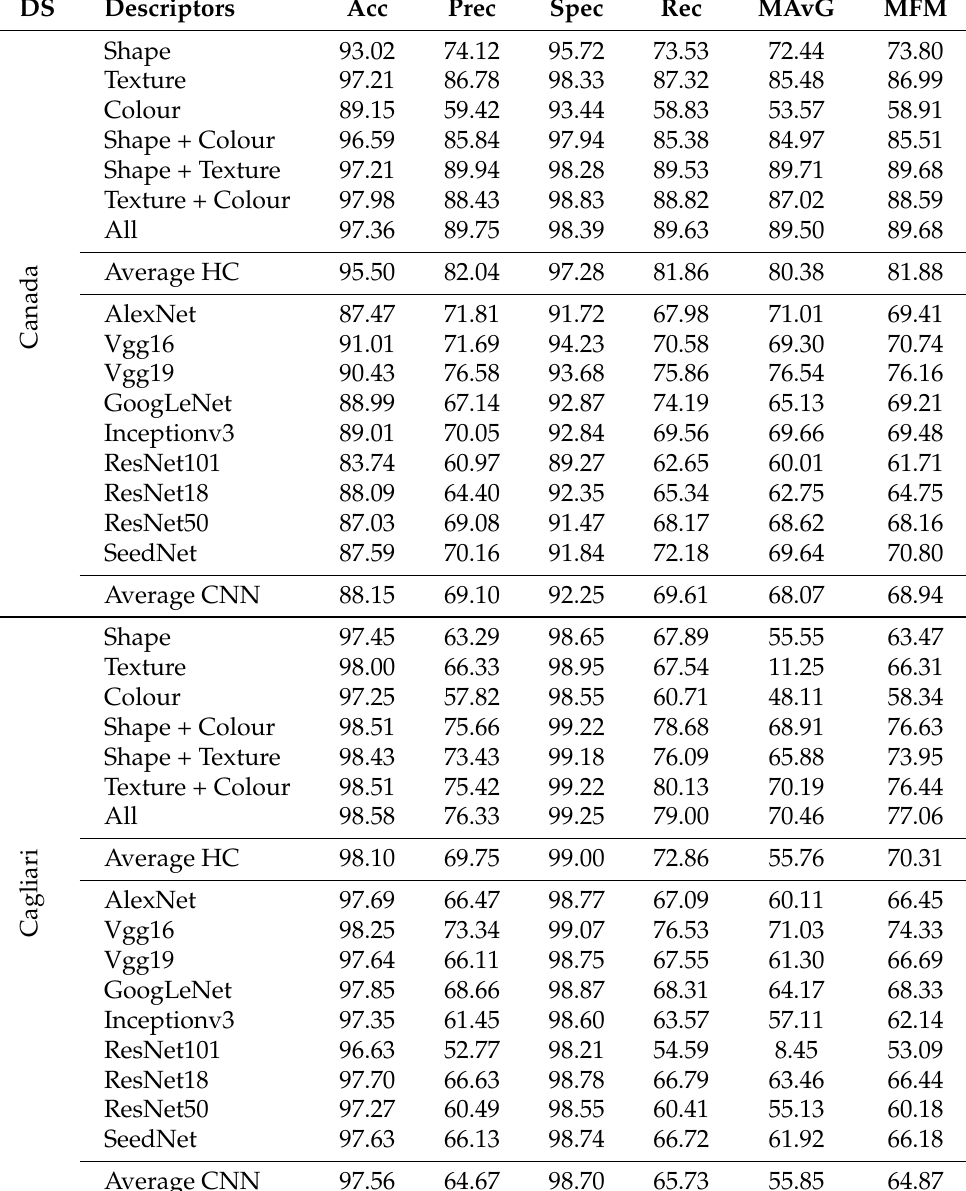
Table A2. Performance results attained using HC descriptors and deep features by Decision Tree classifier on Canada and Cagliari data sets. Decision Tree were trained with 50 as maximum number of splits. DS indicates the data